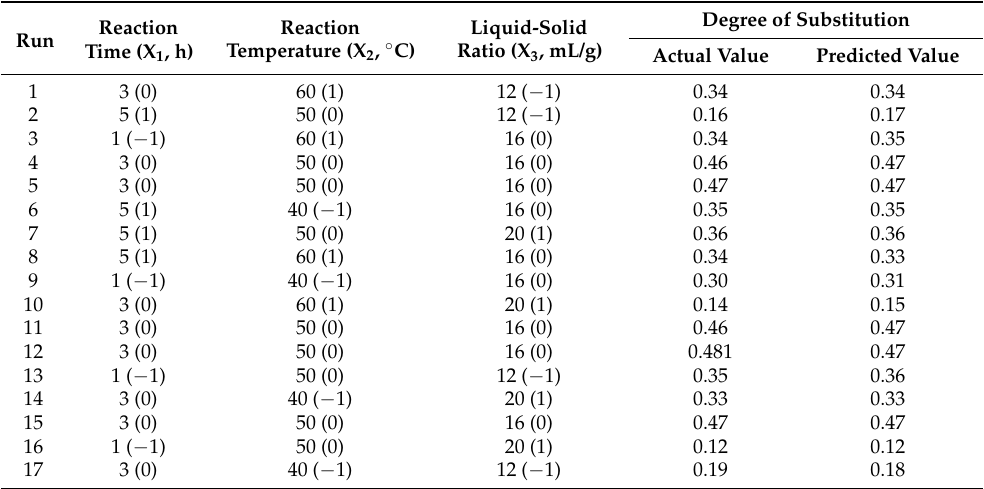
Table 1. Experimental design and the results of the Box–Behnken design.